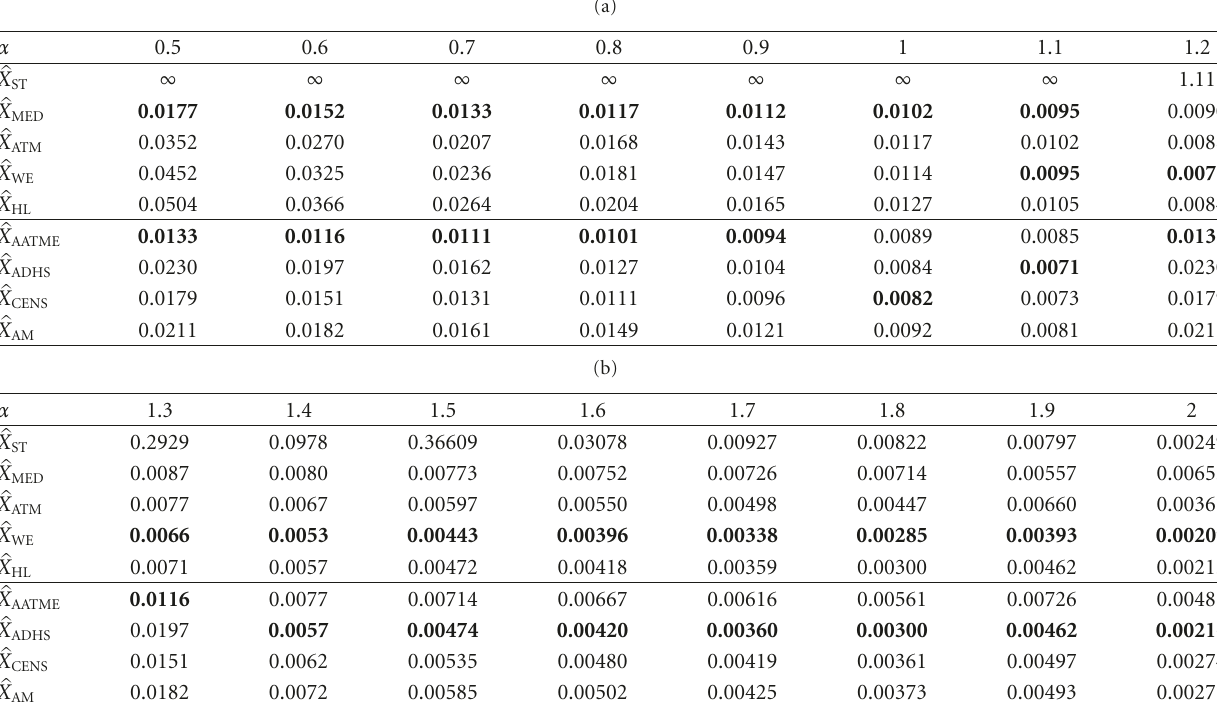
Table 4: MSE values of spectrum estimation for FM signal s 2 ( n ) corrupted by noise ( γ =